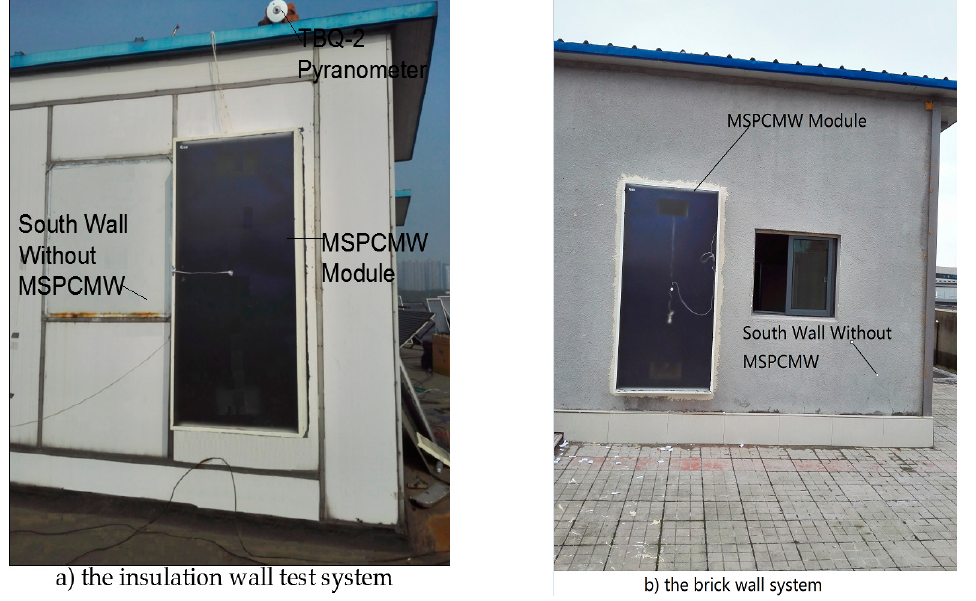
Figure 2. Exterior view of the two test systems: ( a ) the insulation wall test system and ( b ) the brick wall test system.